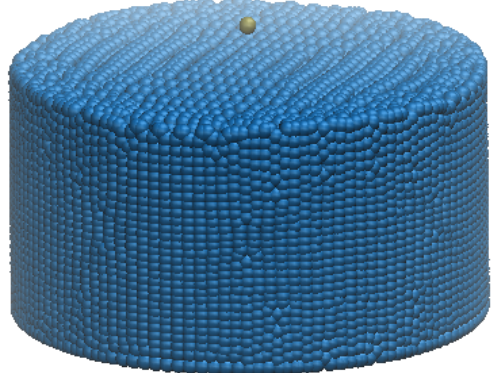
Figure 3. Sedimentation of a single DEM particle among SPH liquid particles.